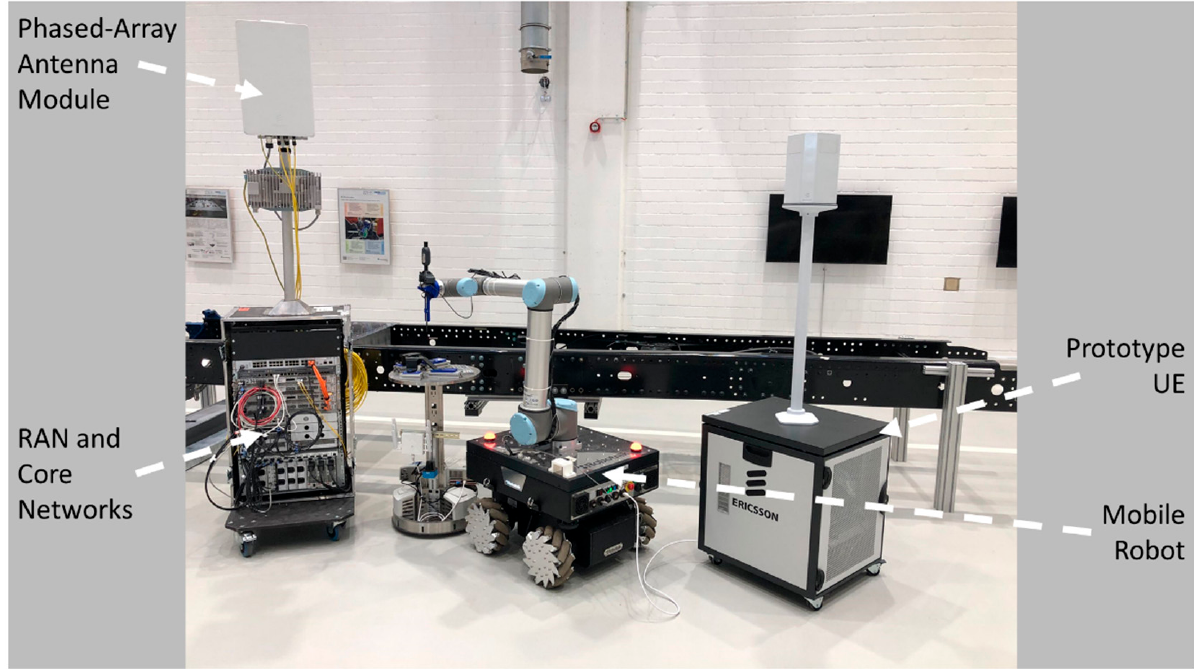
Figure 4. Setup of the URLLC testbed and the mobile robot in a shopfloor environment.